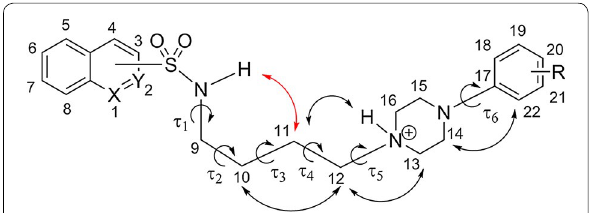
Fig. 3 Numbering system used in X-ray and NMR analysis of